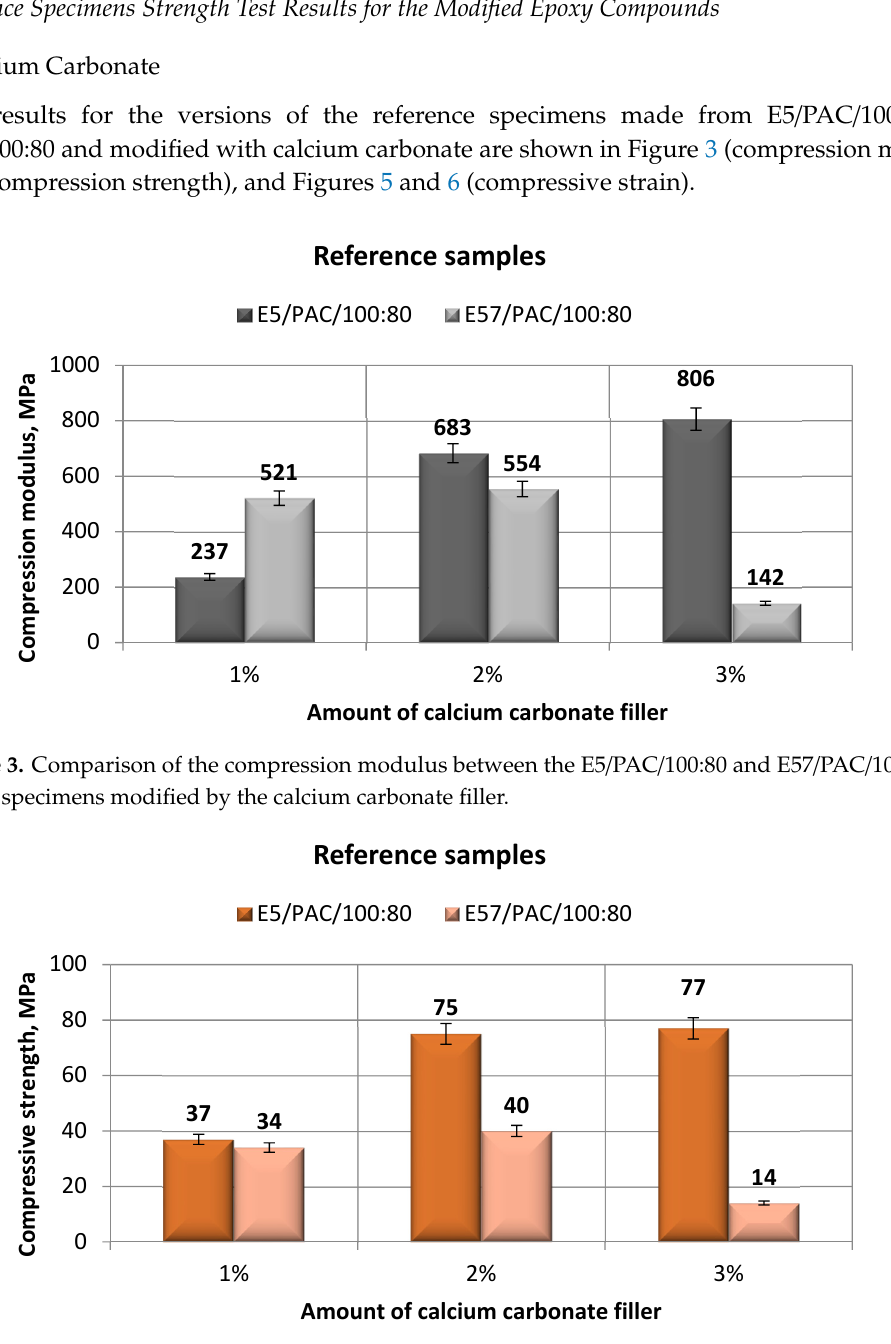
Figure 4. Comparison of the compressive strength between the E5/PAC/100:80 and E57/PAC/100:80 epoxy specimens modified by the calcium carbonate filler.